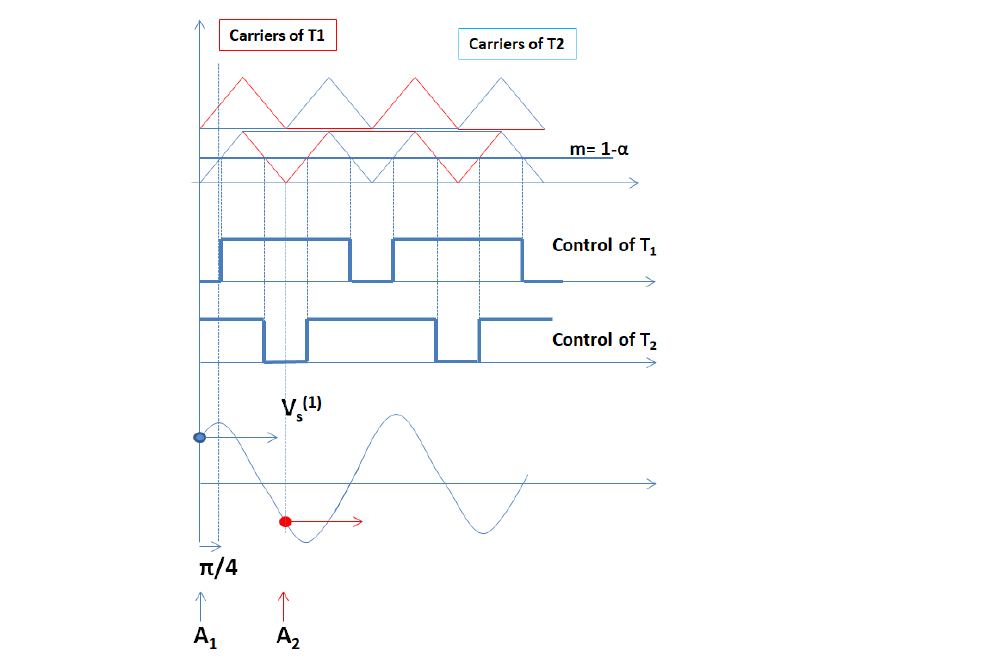
Figure 7. Modified phase shift carriers for three-level voltage corresponding to 0 < m < 1/2 and acquisitions at each switching period of the two defining fundamental points.